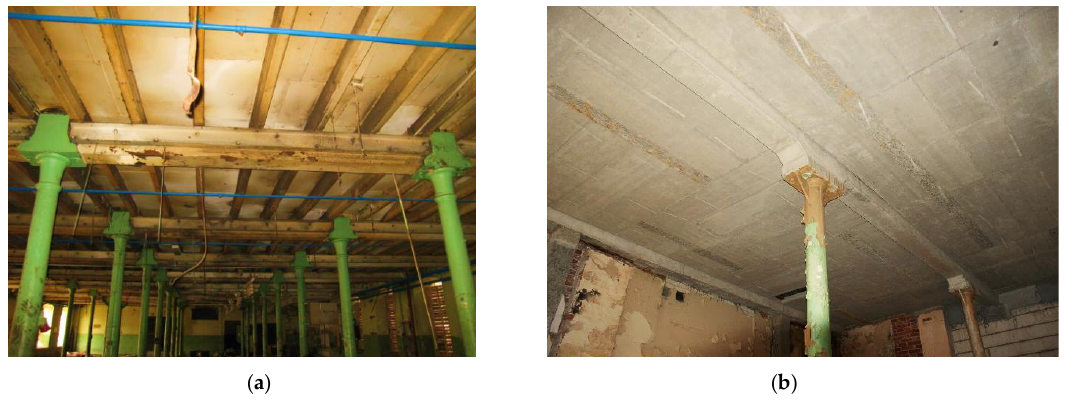
Figure 15. View of the ceilings in the factory building: ( a ) before the commencement of works, ( b ) during reconstruction.